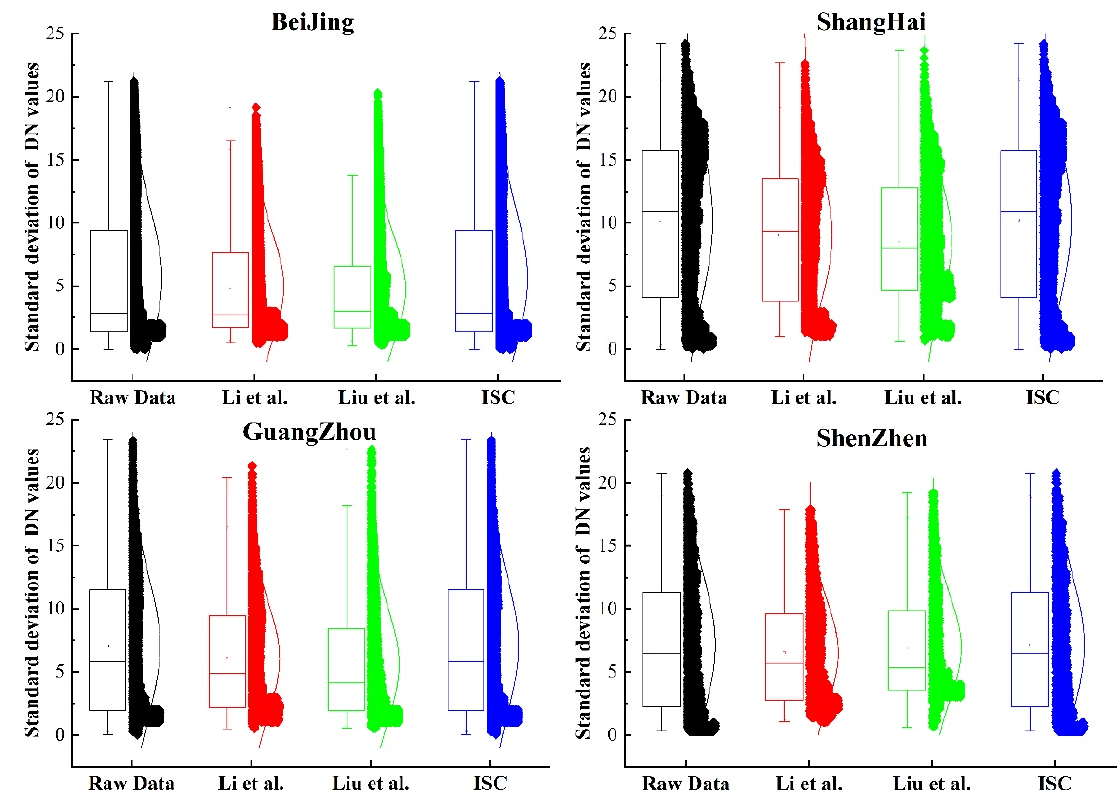
Figure 12. Standard deviation box plots of three different calibration methods in typical cities.